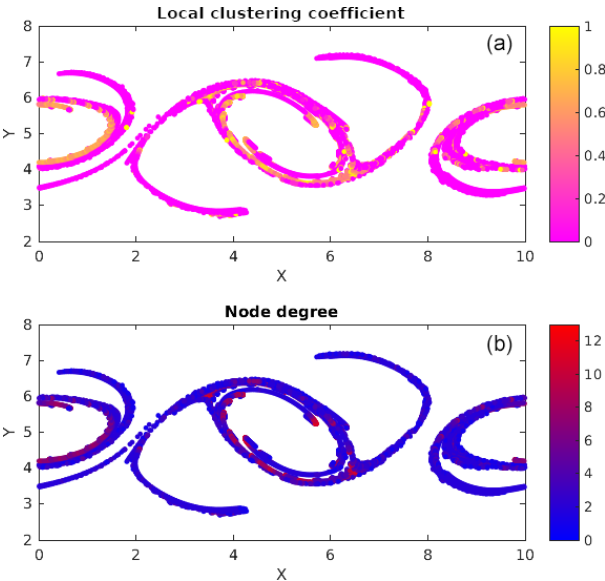
Figure 6. Local clustering coefficient (a) and node degree (b) for the top four cumulative clusters at output time